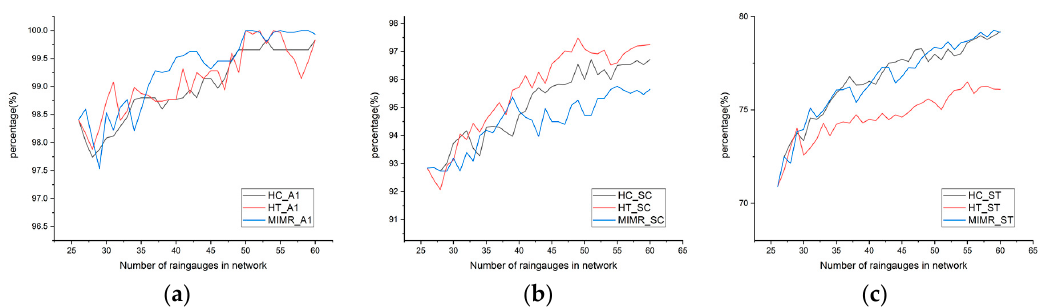
Figure 5. Comparison of the proportions of network joint entropy. ( a ) Statistical results of three networks based on the A1 discrete method; ( b ) Statistical results of three networks based on the SC discrete method; ( c ) Statistical results of three networks based on the ST discrete method.